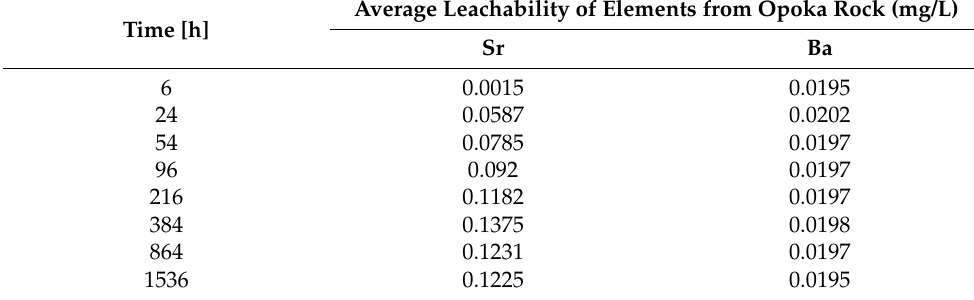
Table 2. The mean rates of leaching of Sr and Ba from opoka rocks over successive time steps.